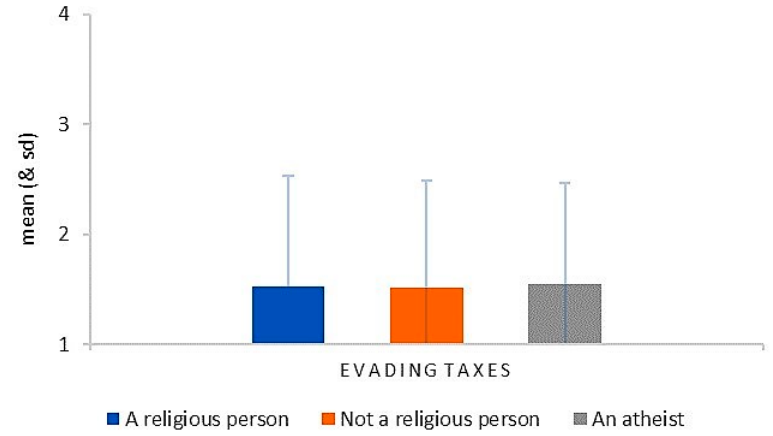
Figure 12. Evading taxes by religious self-declaration. (The error bars represent standard deviation).